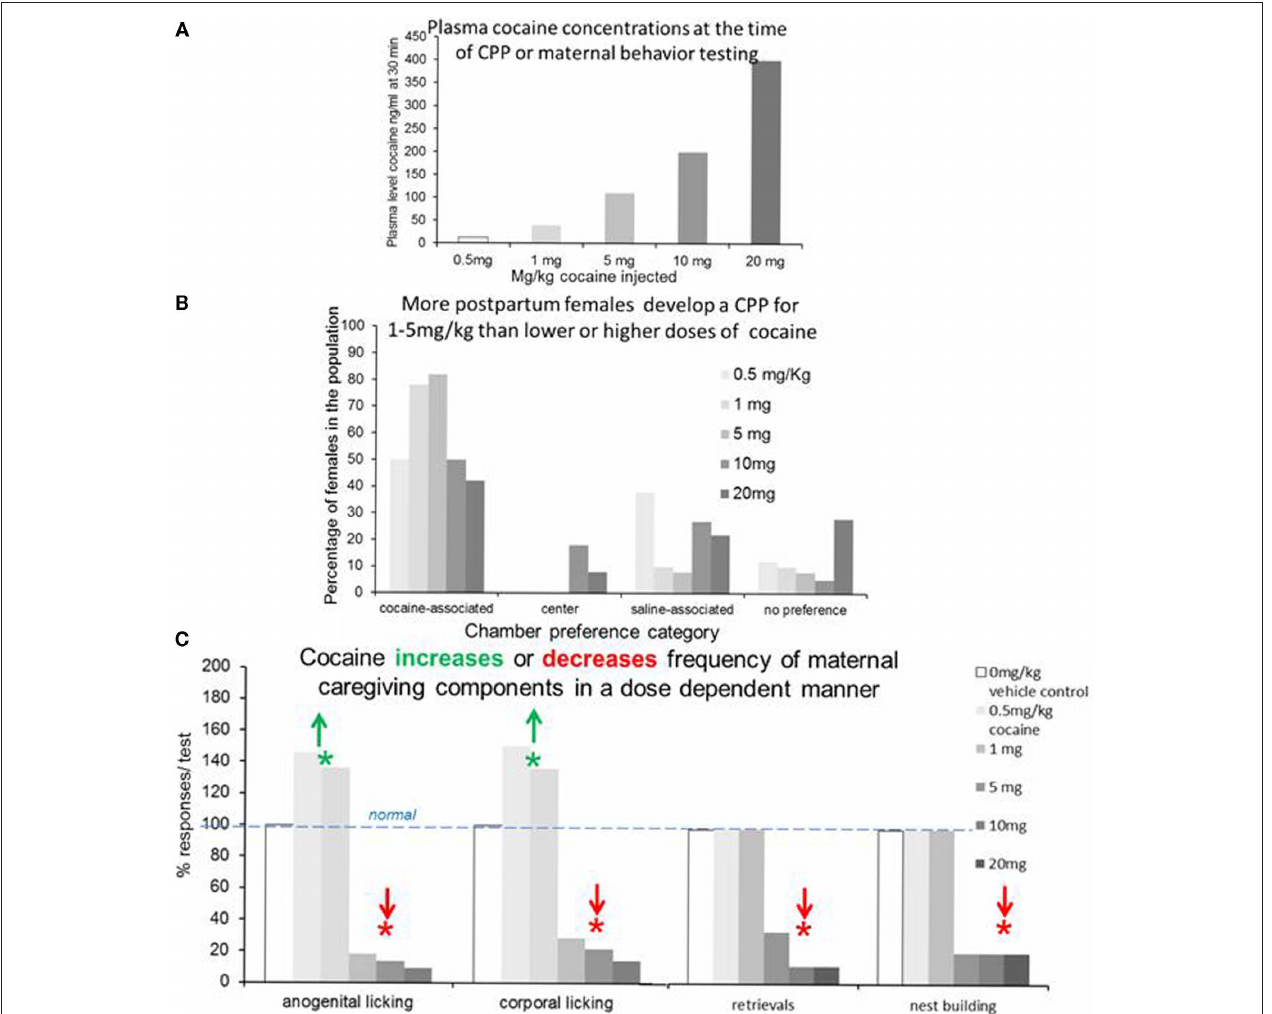
Figure 1 | This is a composite summary representation of published and emerging findings from multiple experiments in our laboratory. (A) Plasma levels of cocaine in independent groups of postpartum females in the acute phase of their drug exposure, 30 min after cocaine injection (Vernotica et al., 1996; Wansaw et al., 2005; Basso and Morrell, in preparation). (B) Individual preference for uniquely decorated chambers associated with cocaine in the postpartum female rat during the postconditioning test session in the absence of cocaine. The percentage of the postpartum females with a preference for the